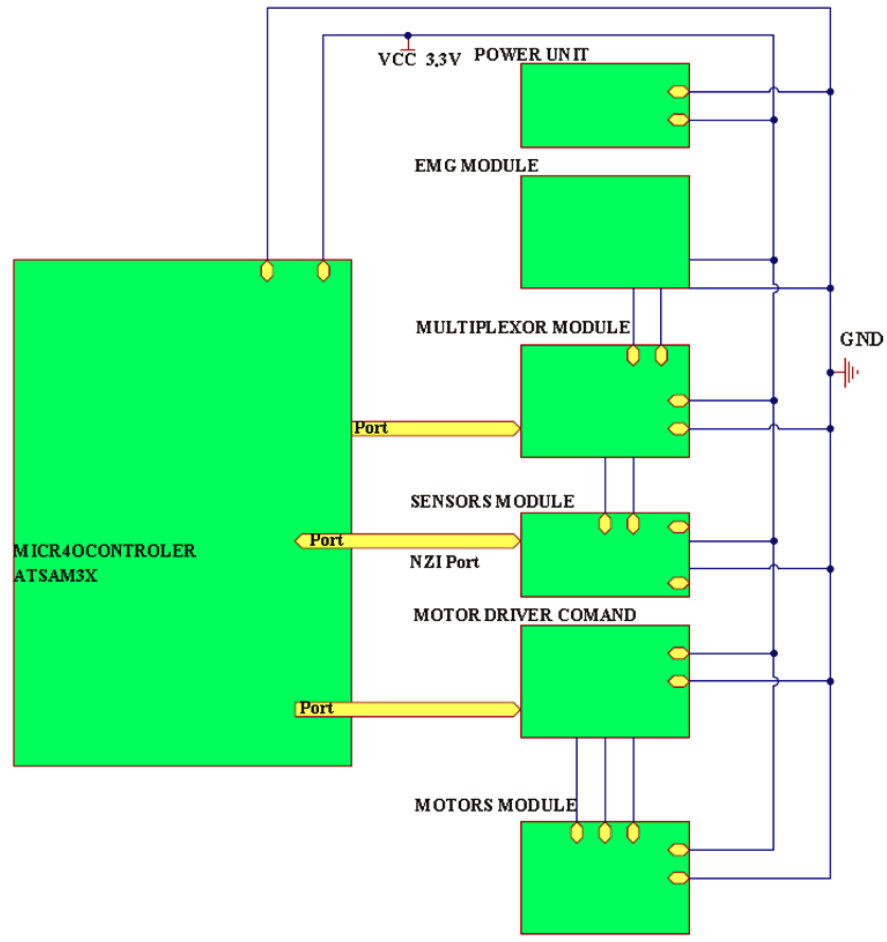
Figure 14. Block diagram of the command and control system for the upper limb prosthesis.